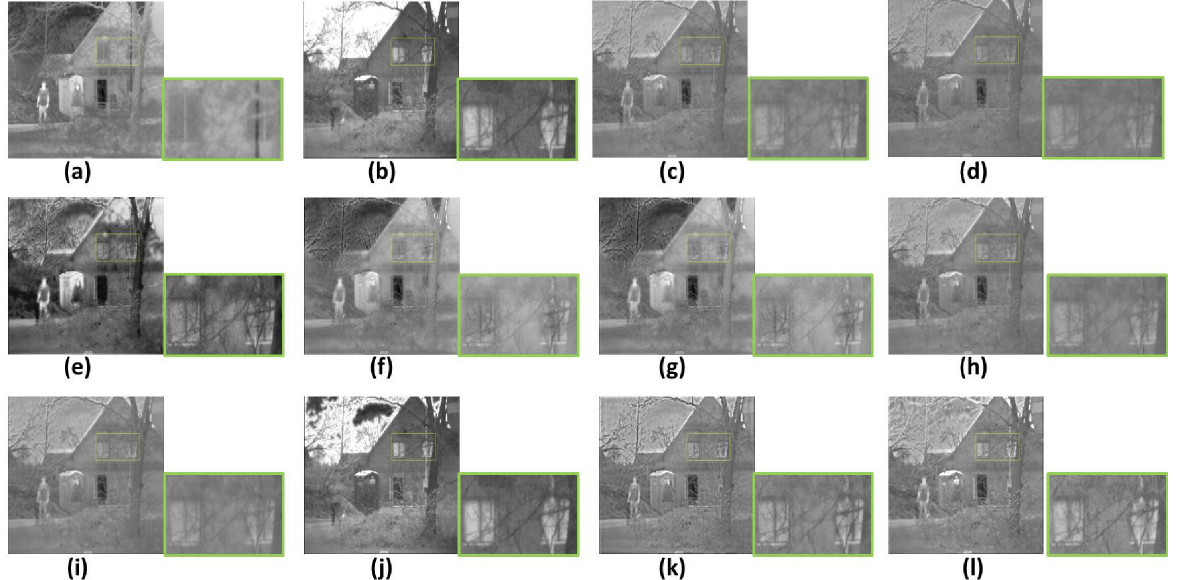
Figure 6. Visual IF results of different methods on two men in front of house : ( a ) IR image, ( b ) VIS image, ( c ) Proposed method, ( d ) [17], ( e ) [22], ( f ) [33], ( g ) [20], ( h ) [34], ( i ) [35], ( j ) [36], ( k ) [37], and ( l )